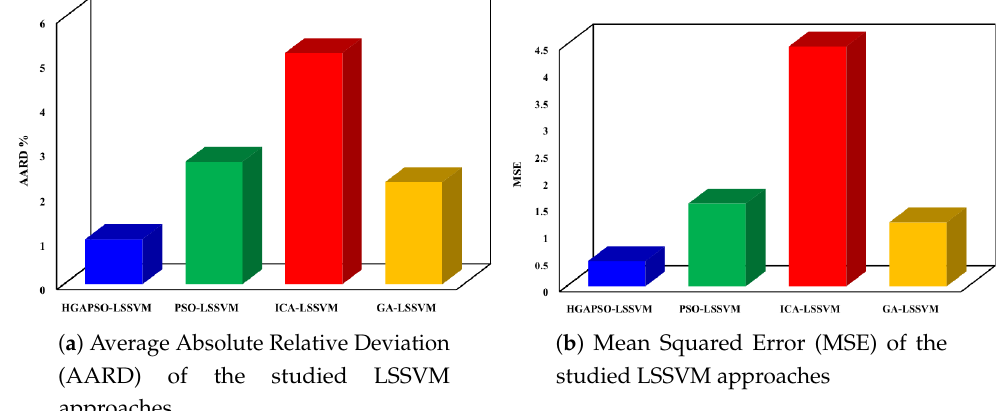
Figure 9. Errors for the LSSVM-based models.